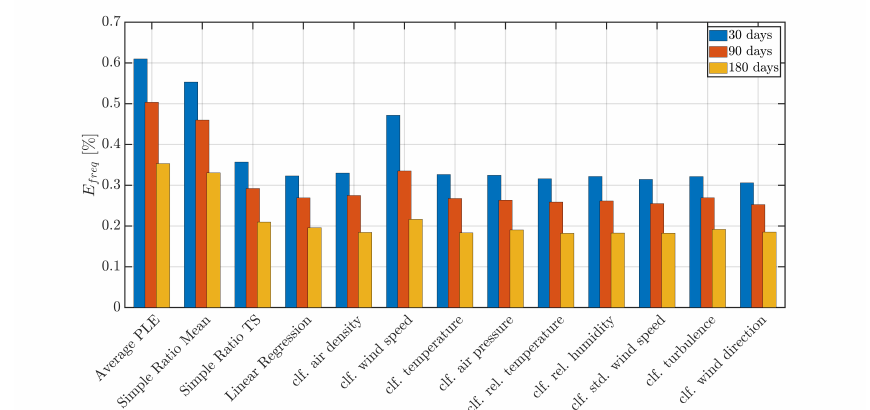
Figure 7. Extrapolation errors E freq for z 2 = 80 m , z t = 140 m and varying durations of the lidar measurement; for extrapolation without short-term lidar data, E freq =